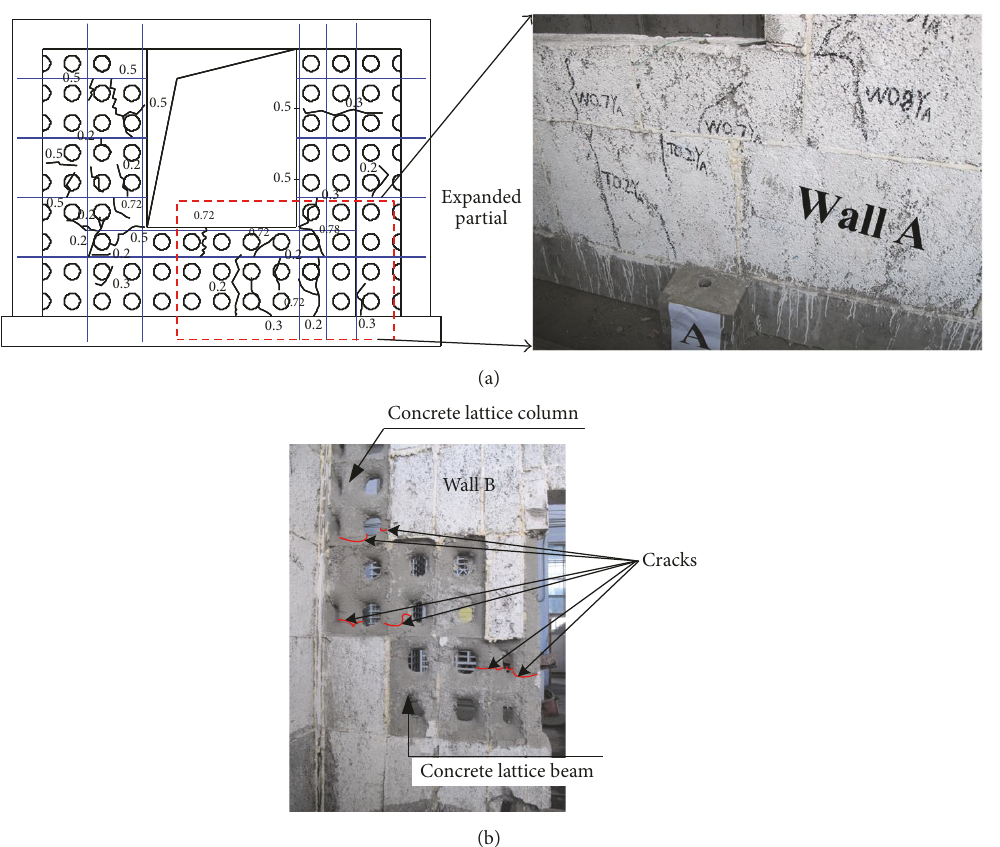
Figure 10: Observed cracks in the model structure: (a) EPSC latticed concrete wall A and (b) EPSC latticed concrete wall B.